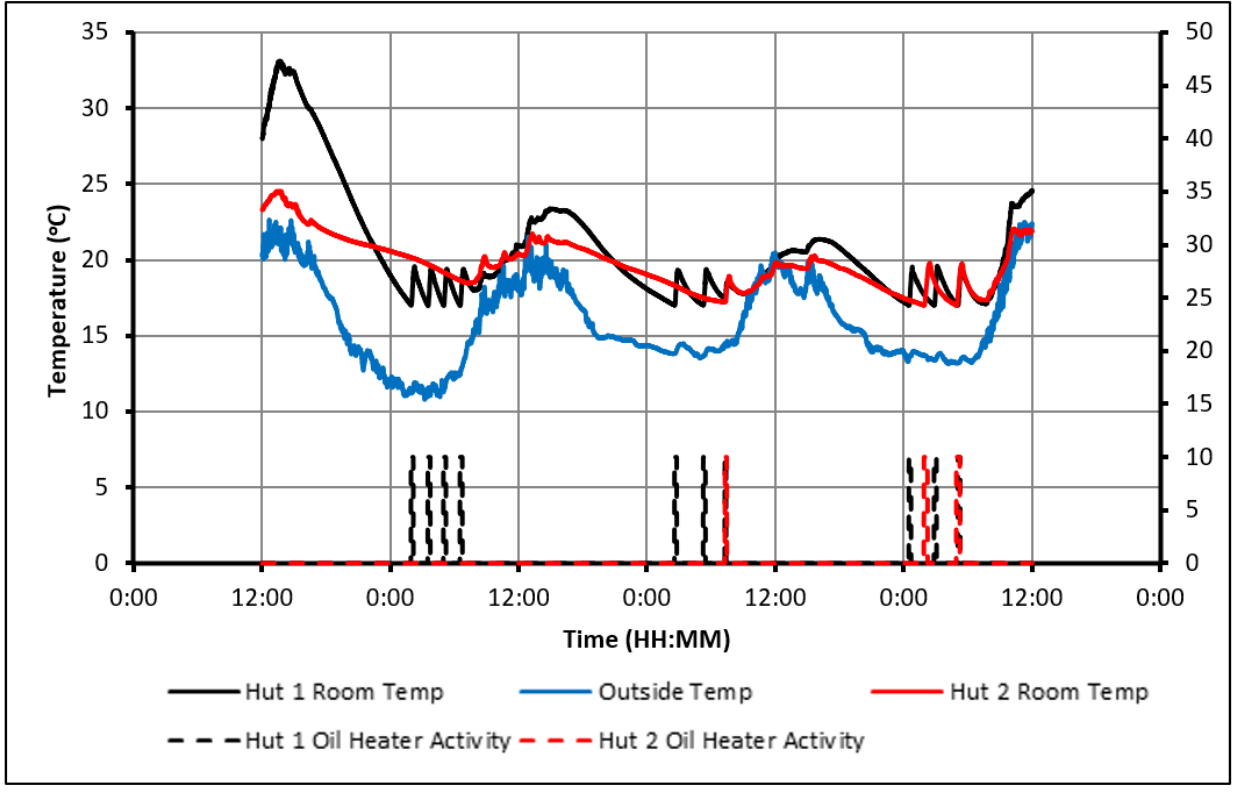
Figure 13. Temperature profiles and heater activity (17 – 19 °C temp constraints, 72-h period).